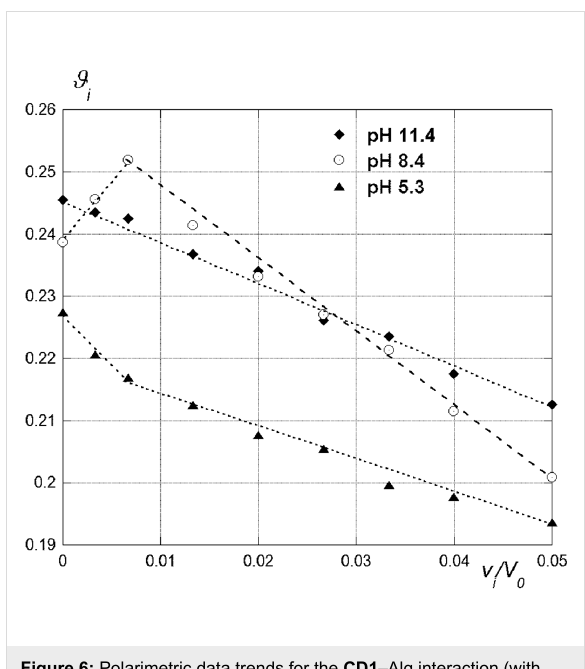
Figure 6: Polarimetric data trends for the CD1 –Alg interaction (with buffer).